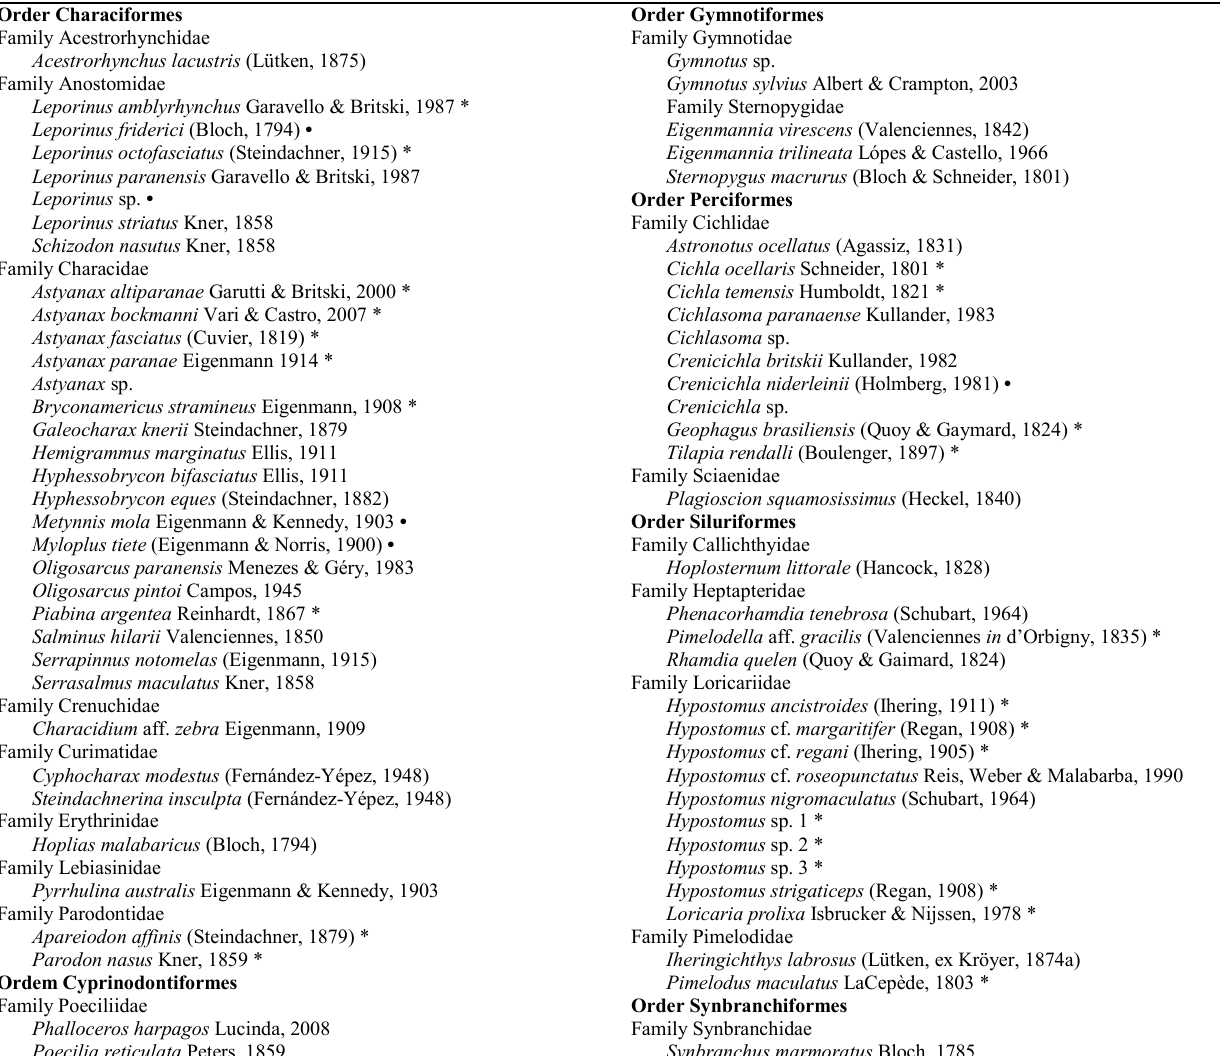
Table 1 . Taxonomic list of the fish caught in Ourinhos Dam in 2008-2009. • Species caught only downstream from the dam. * Species caught in the fish